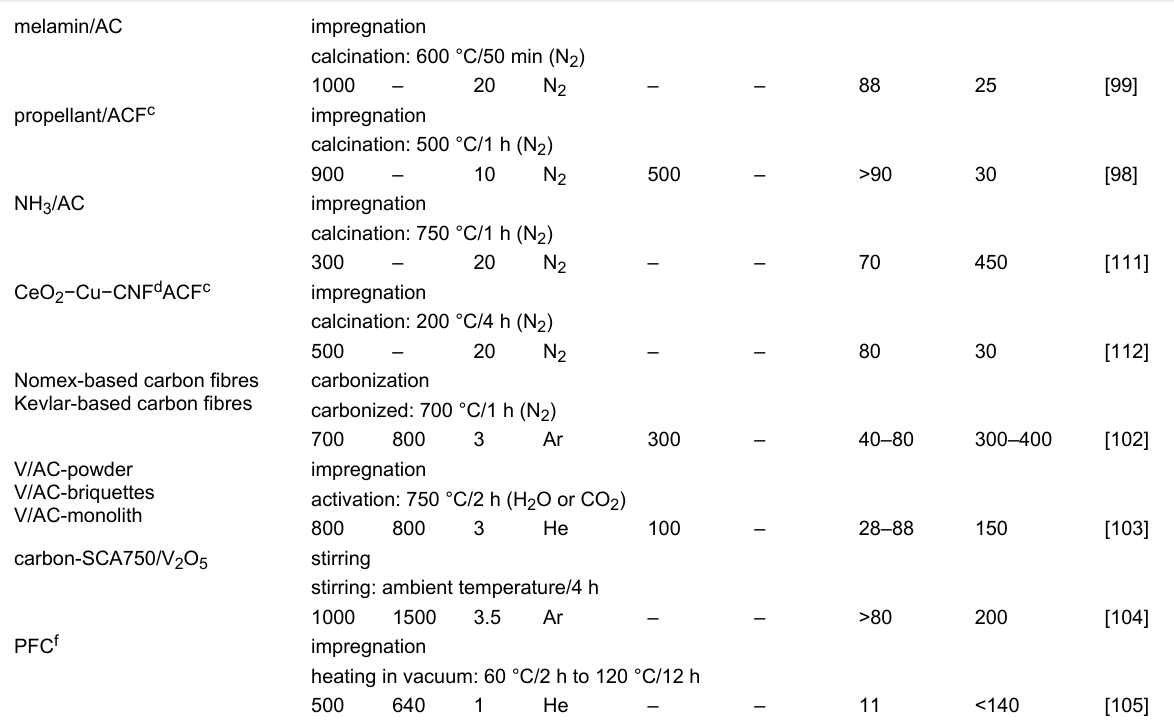
Table 3: Summary on the reaction conditions and NO activity for activated carbon and activated carbon fiber supported based catalysts. (continued)